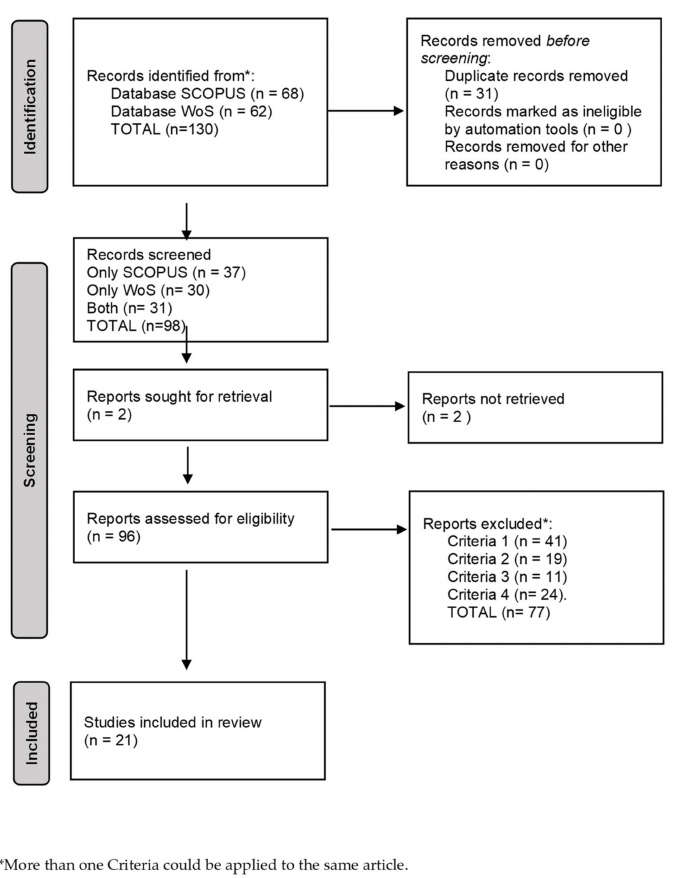
Figure 1. PRISMA 2020 flow diagram for new systematic reviews which included searches of databases and registers